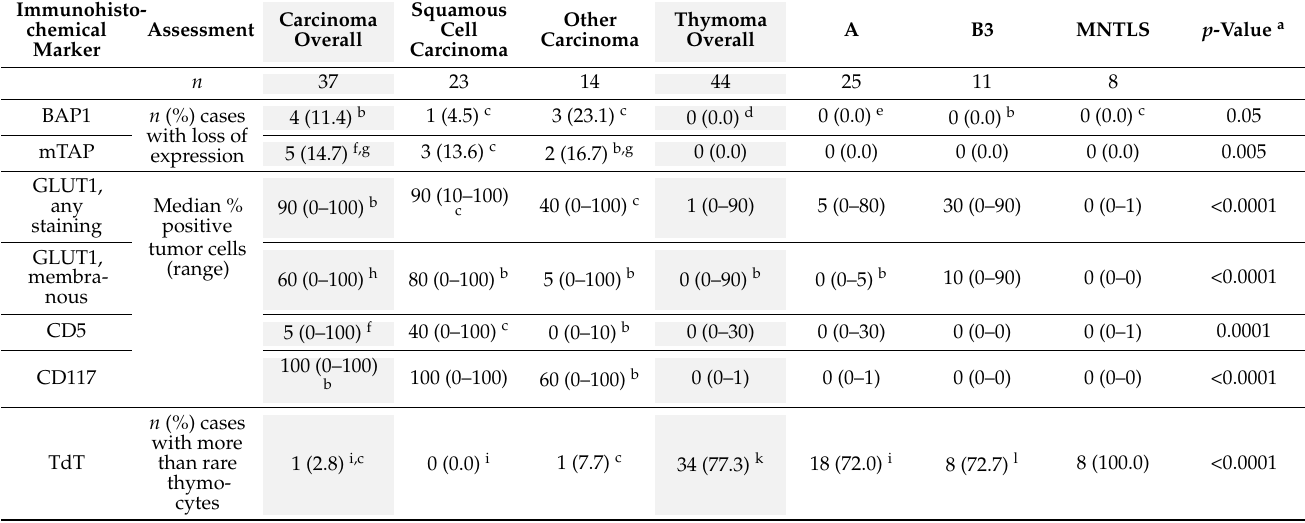
Table 2. Results of